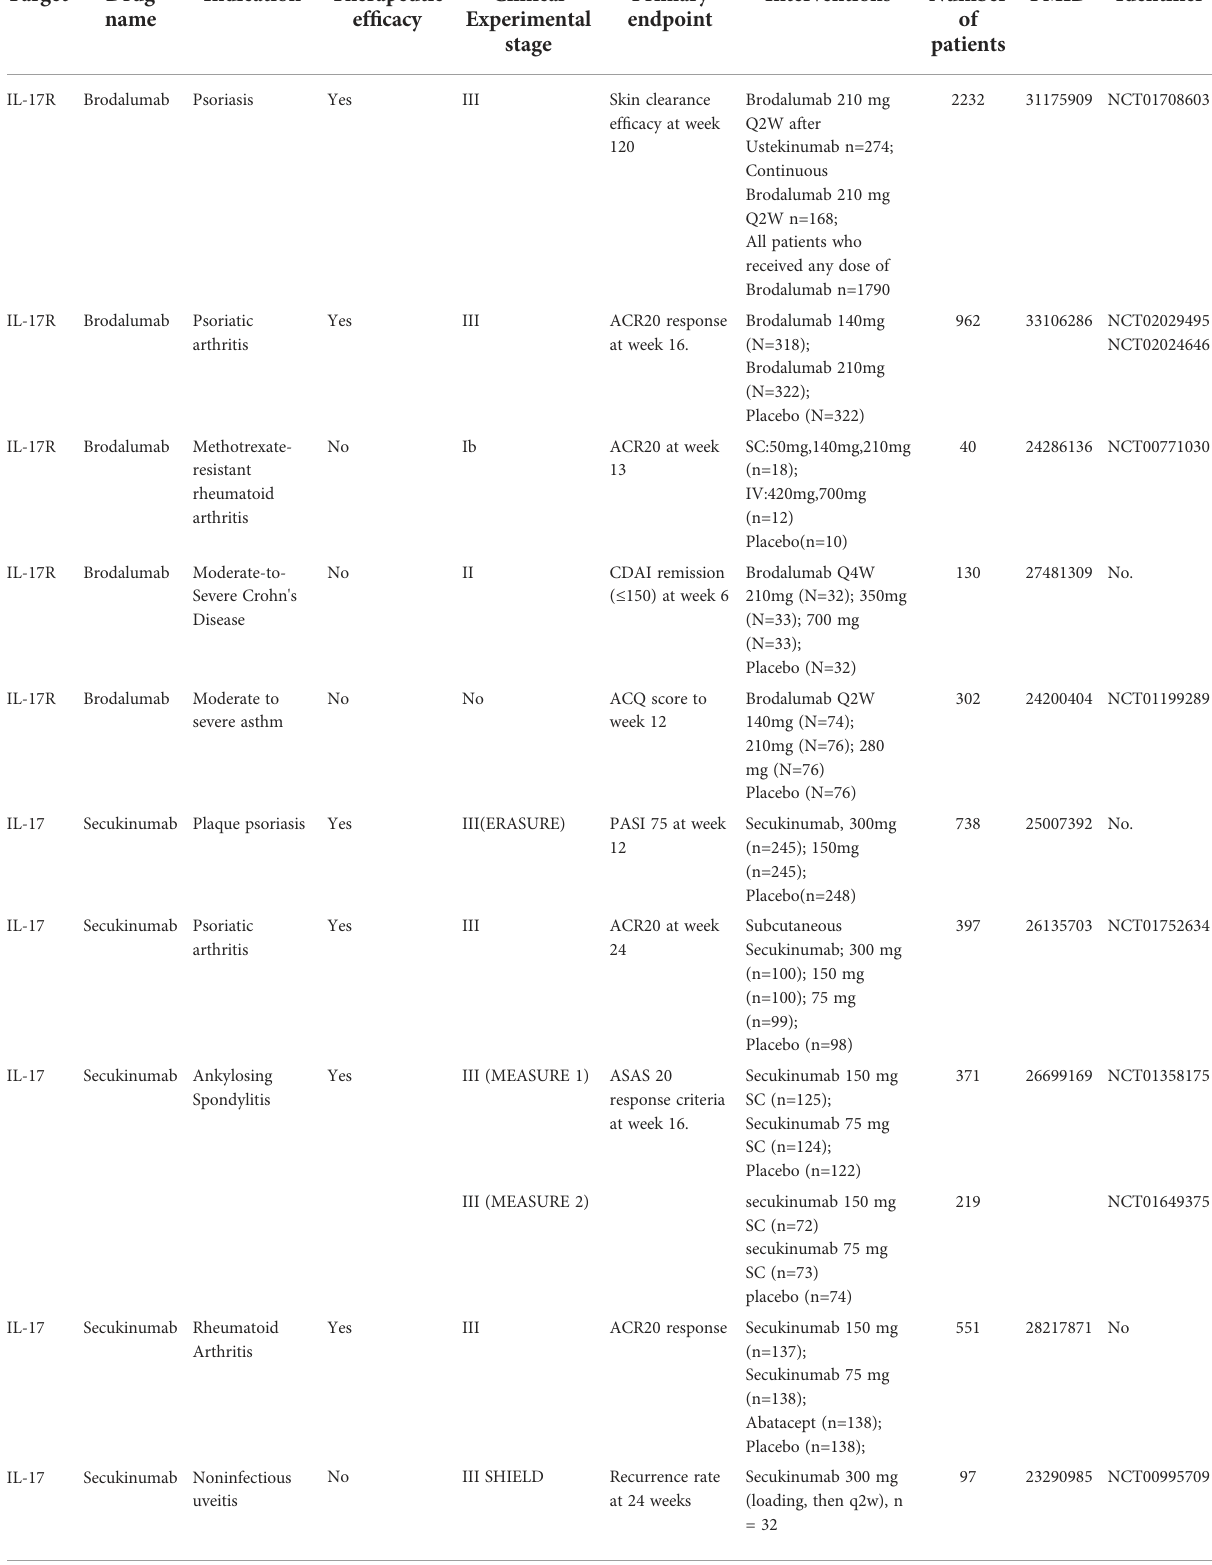
TABLE 2 Summary of IL-17/IL-17R drug targeting in various